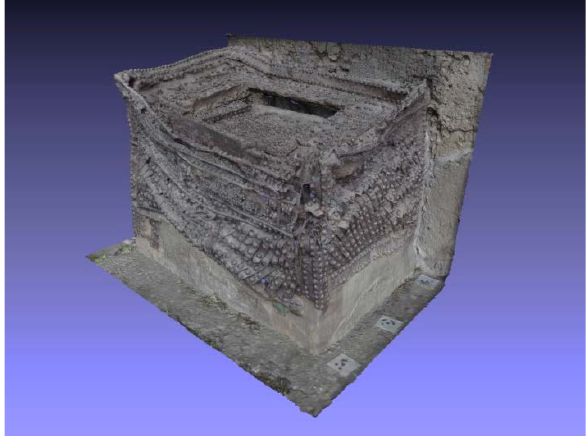
Figure 11. Final 3D model of the